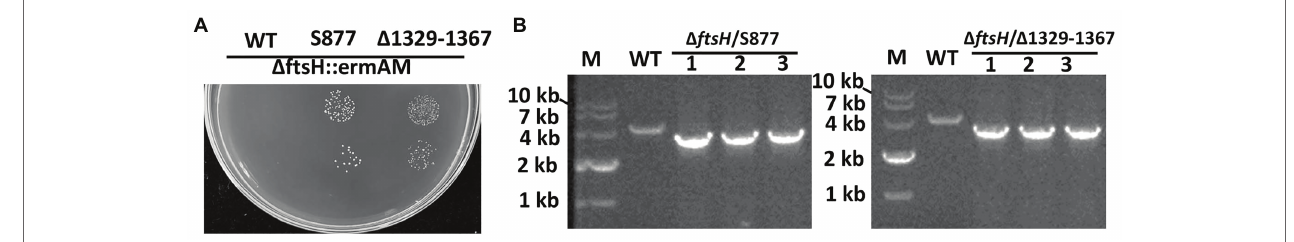
FIGURE 4 | Both vicR (G195R) point mutation and Tnsmu2 deletion can suppress ftsH mutant lethality. (A) The ftsH deletion construct ∆ ftsH::ermAM was transformed into following strains: wild type strain UA159, the markerless vicR (G195R) point mutation strain (S877), and the markerless TnSmu2 deletion strain ( ∆ 1329–1367). About 10 μ l of each transformation reaction (10 0 and 10 −1 dilutions) was spotted onto selective medium. This experiment was performed three times with similar results. (B) Three randomly selected transformants of strain (S877) and strain ( ∆ 1329–1367) were PCR amplified using primers flanking the ftsH locus to confirm the ftsH deletion genotype. The expected PCR amplicons from the wild type (WT) is approximately 4 kb, while the expected ftsH mutant amplicon is approximately 3 kb.